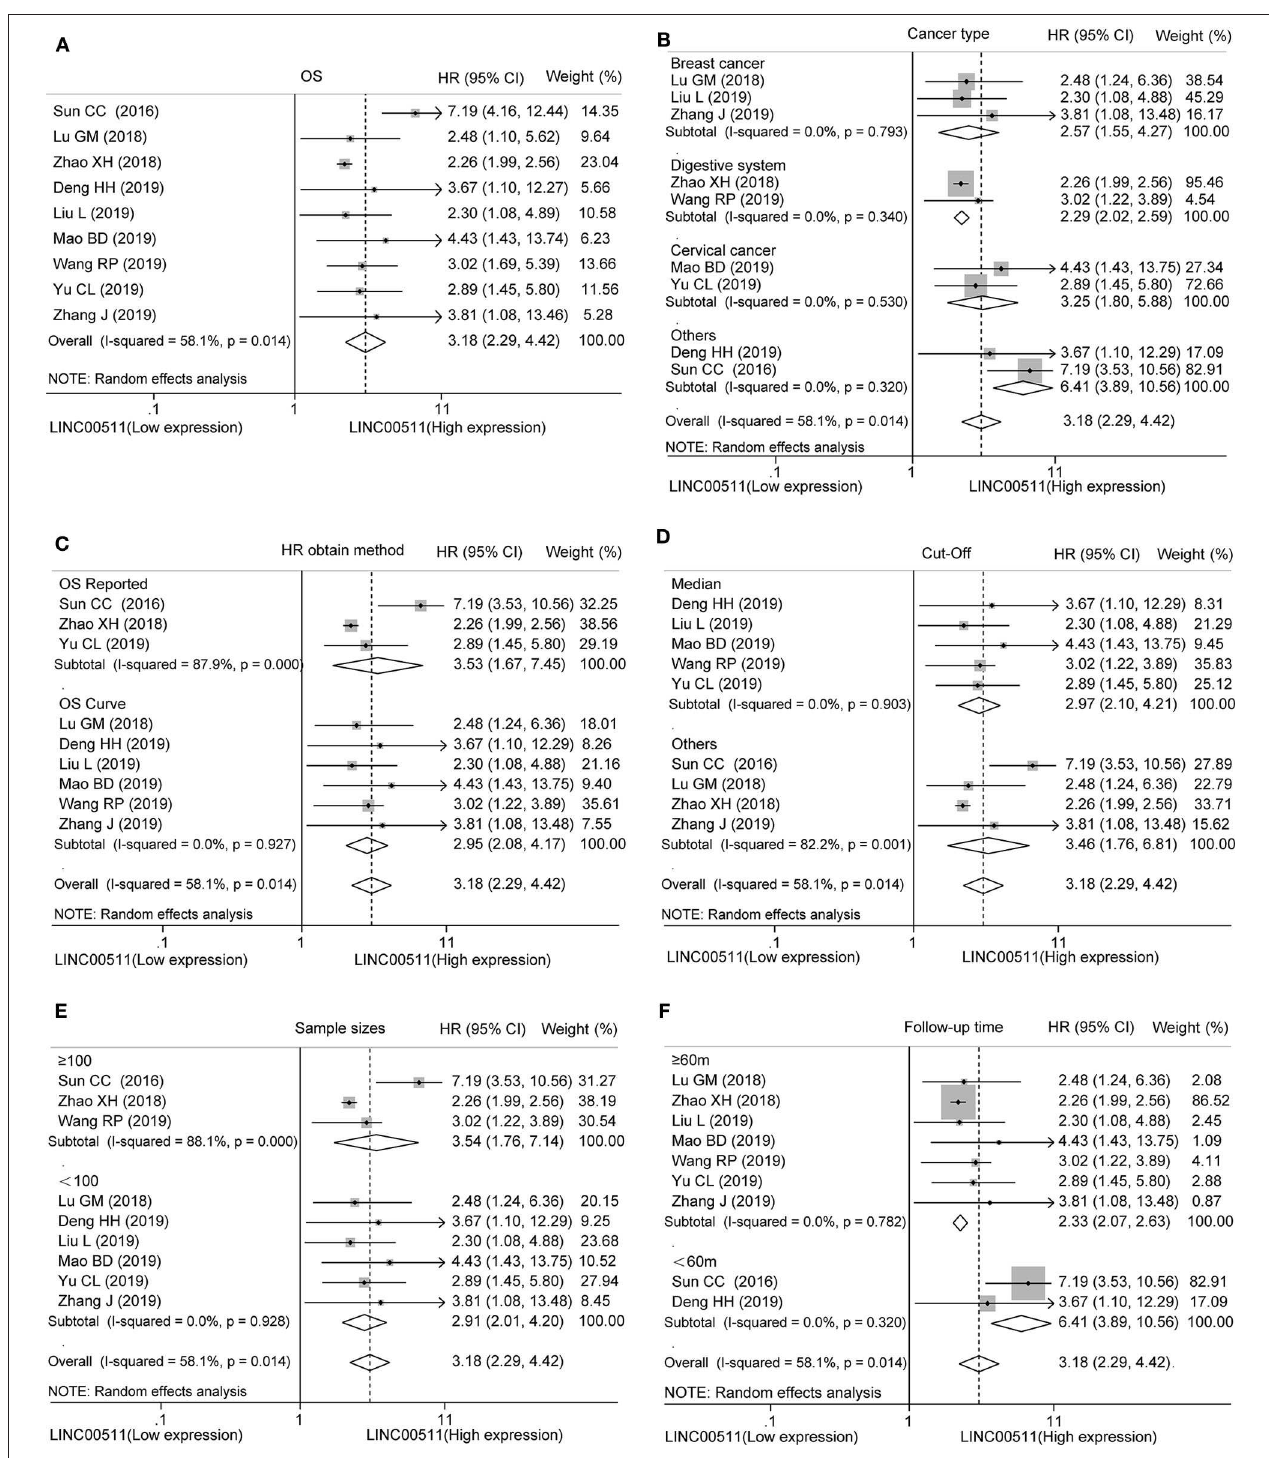
FIGURE 2 | Forest plots of hazard ratios for the association between LINC00511 expression and overall survival. (A) Overall survival, subgroup analysis based on (B) different cancer types, (C) HR obtain method, (D) cut-off, (E) sample size and (F) follow up time.